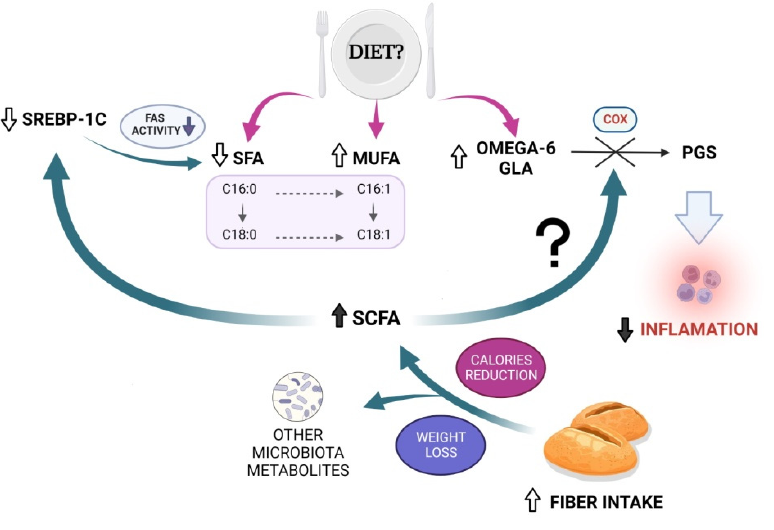
Figure 1. Results of the study and proposed hypothesis.